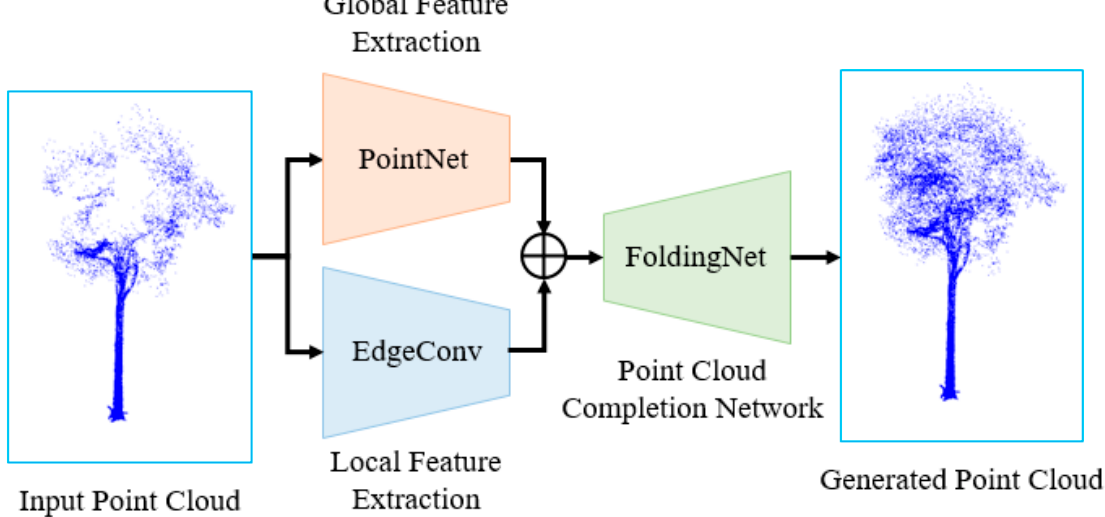
Figure 1. The proposed single-tree point cloud depth completion network architecture.